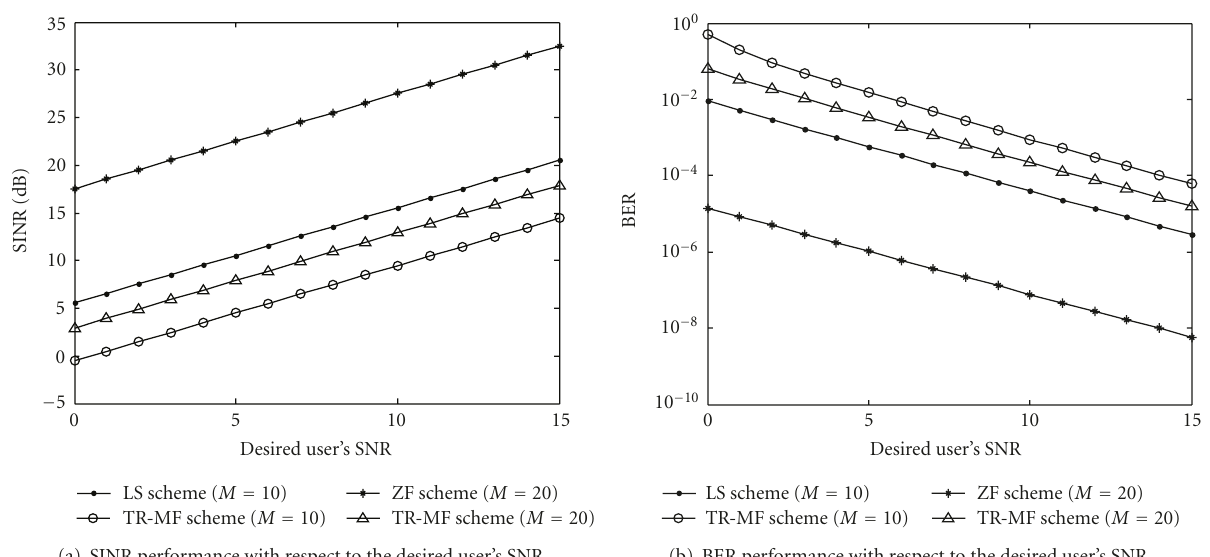
Figure 3: System performance with respect to the desired user’s